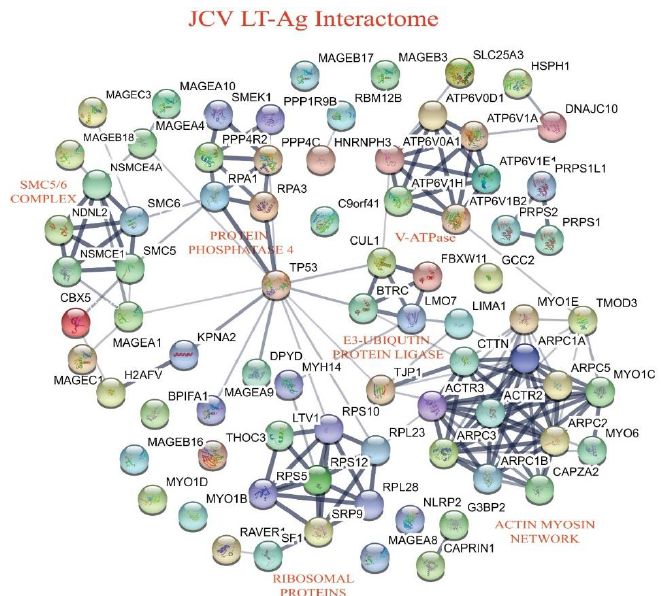
Figure 4. Building an interactome map for the host proteins targeted by JCV LT-Ag using “STRING Figure 4.